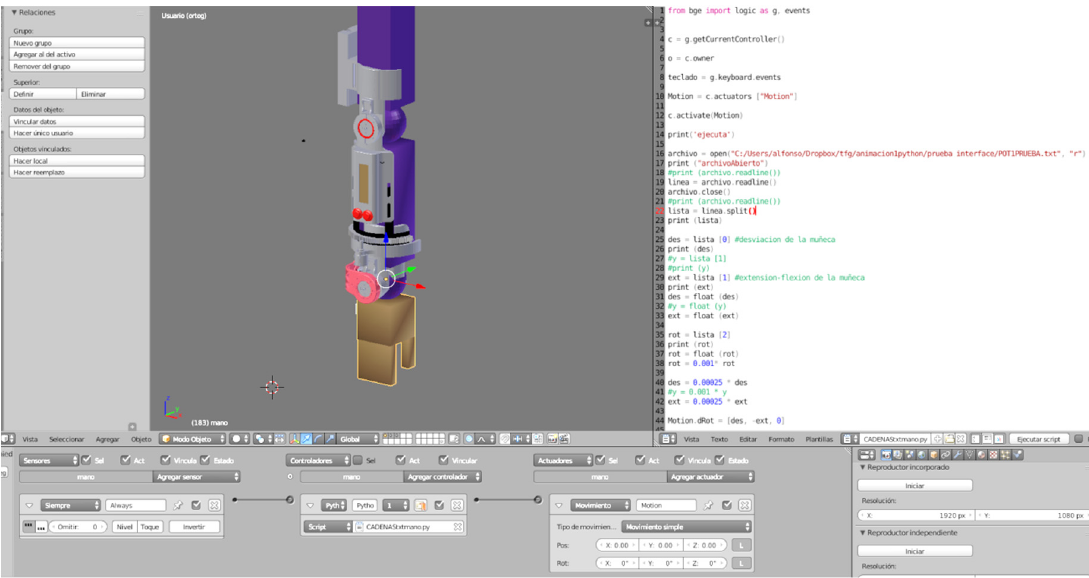
Figure 7. System modeling in Blender. Sensors 2020 , 20 , x FOR PEER REVIEW